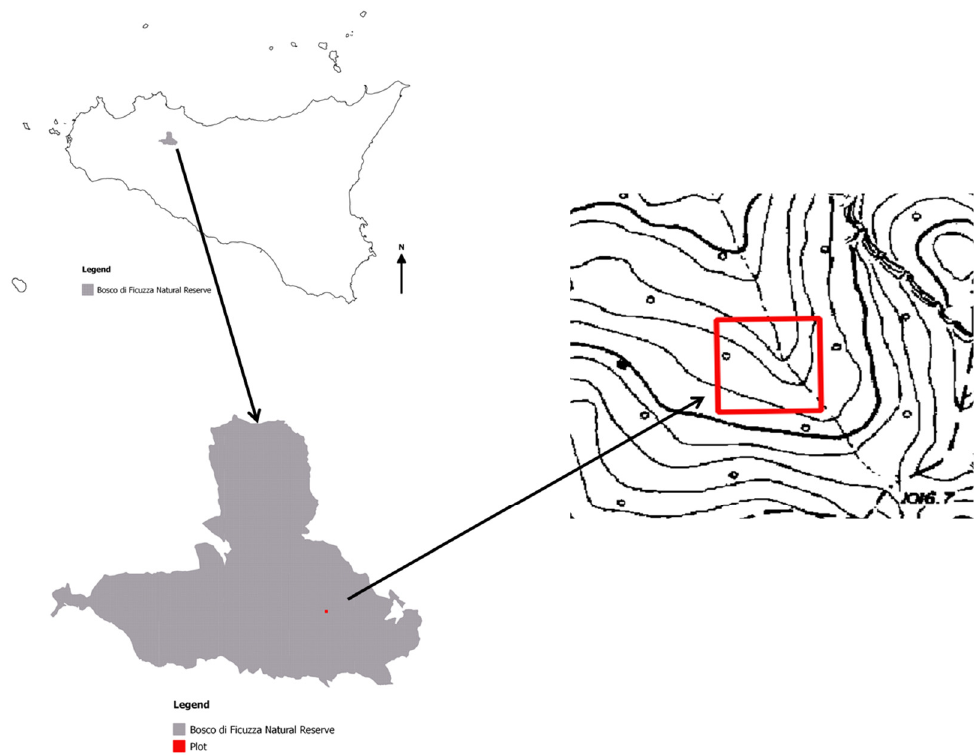
Figure 1. Location of the Reserve within which the experimental plot was established. On the right a detail of the Technical Map of Sicily in 1:10,000 scale.